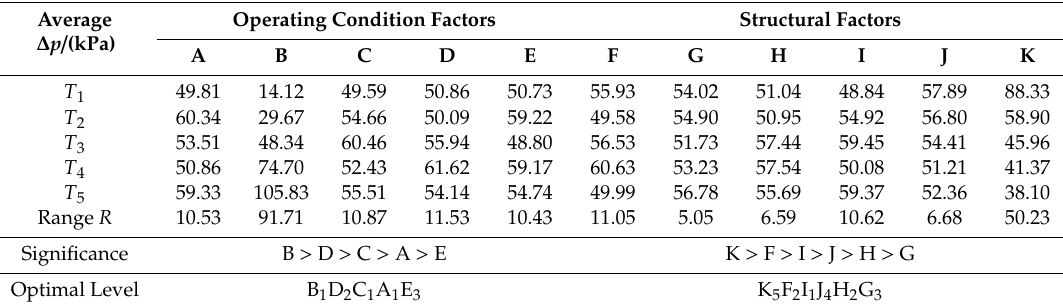
Table 3. Range analysis of each influential factor on ventilation